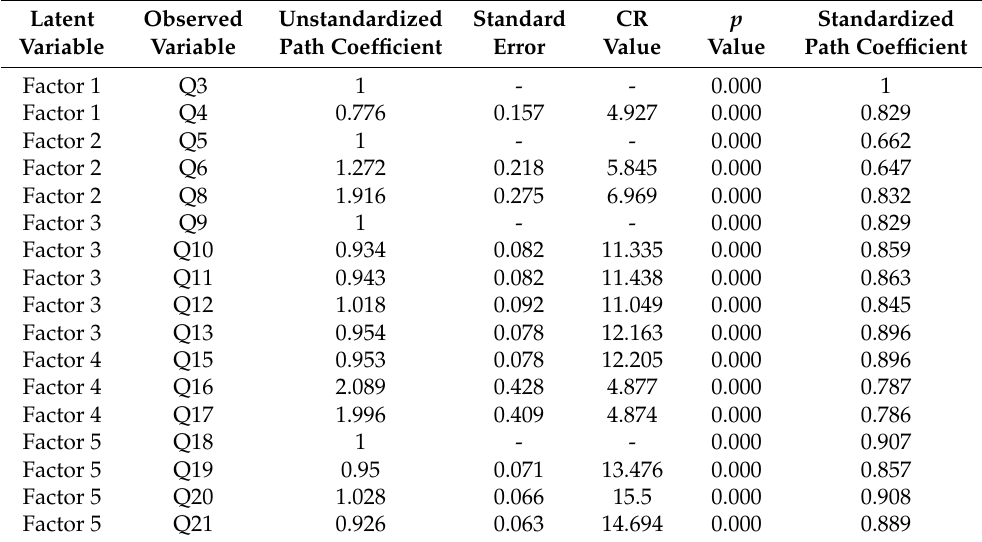
Table 8. Factor load coefficient.